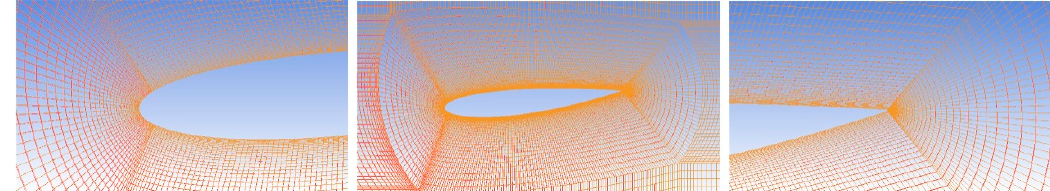
Figure 2. Mesh around NACA0015 at an angle of attack α = 6° (middle); close view of the leading edge region (left); close view of the trailing edge region (right).